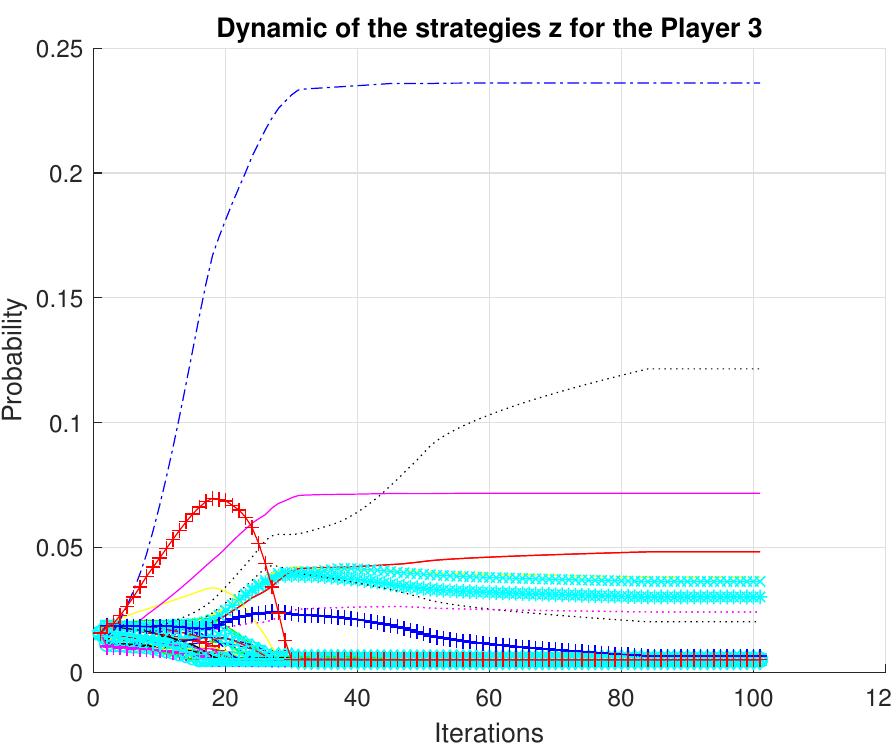
Figure 3. Convergence of strategies z imkk (cid:48) for player